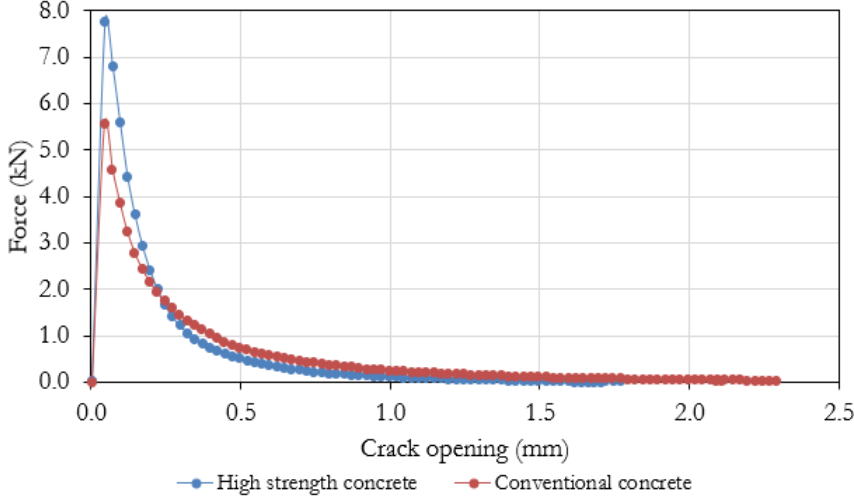
Figure 13. Overlap of the force versus crack width means curves for conventional and HS